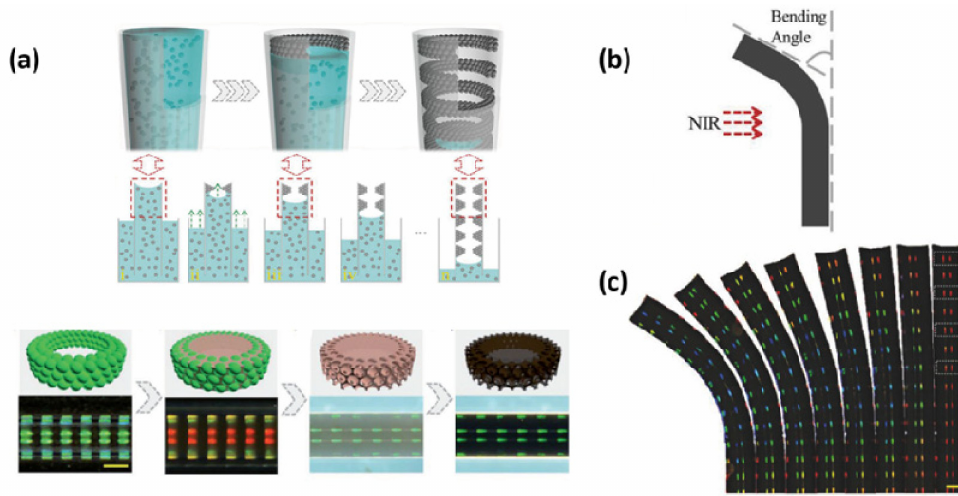
Figure 4. Thermo-responsive PC patterns based on the change in lattice spacing for anti-counterfeiting. ( a ) Formation of a near-infrared (NIR) light-responsive striped Poly(N-isopropyl acrylamide) / reduced graphene oxide (PNIPAM / rGO) fiber with I-opal structure. ( b ) PNIPAM / rGO fiber bending toward the direction of light. ( c ) A group of digital photos showing that the fiber has a varying colored striped pattern at di ff erent bending angles. Reused with permission from Reference [65], Copyright 2017,